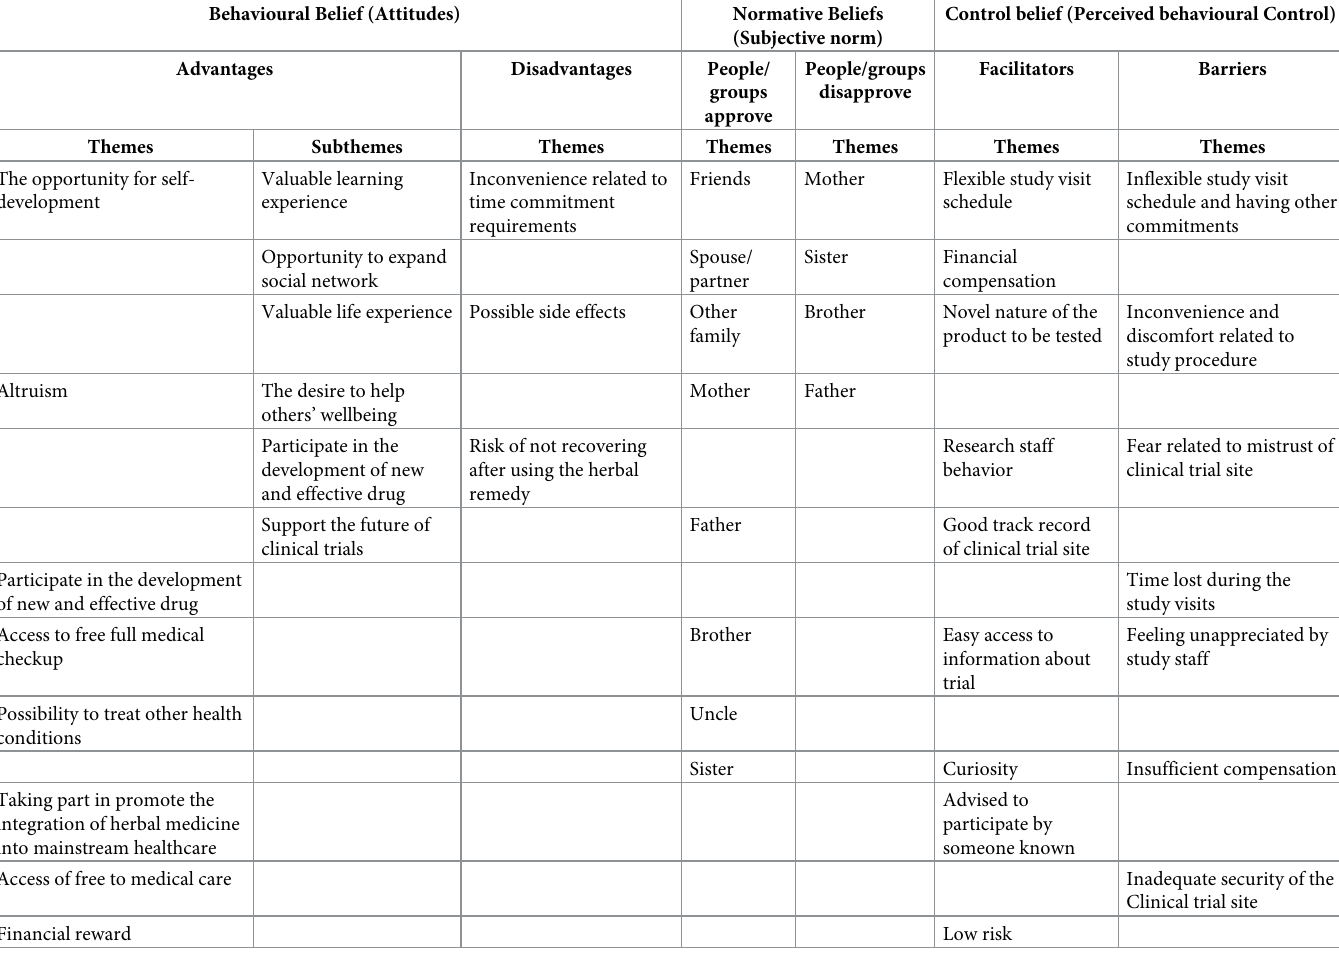
Table 3. Themes and subthemes matched with theory of planned behaviour